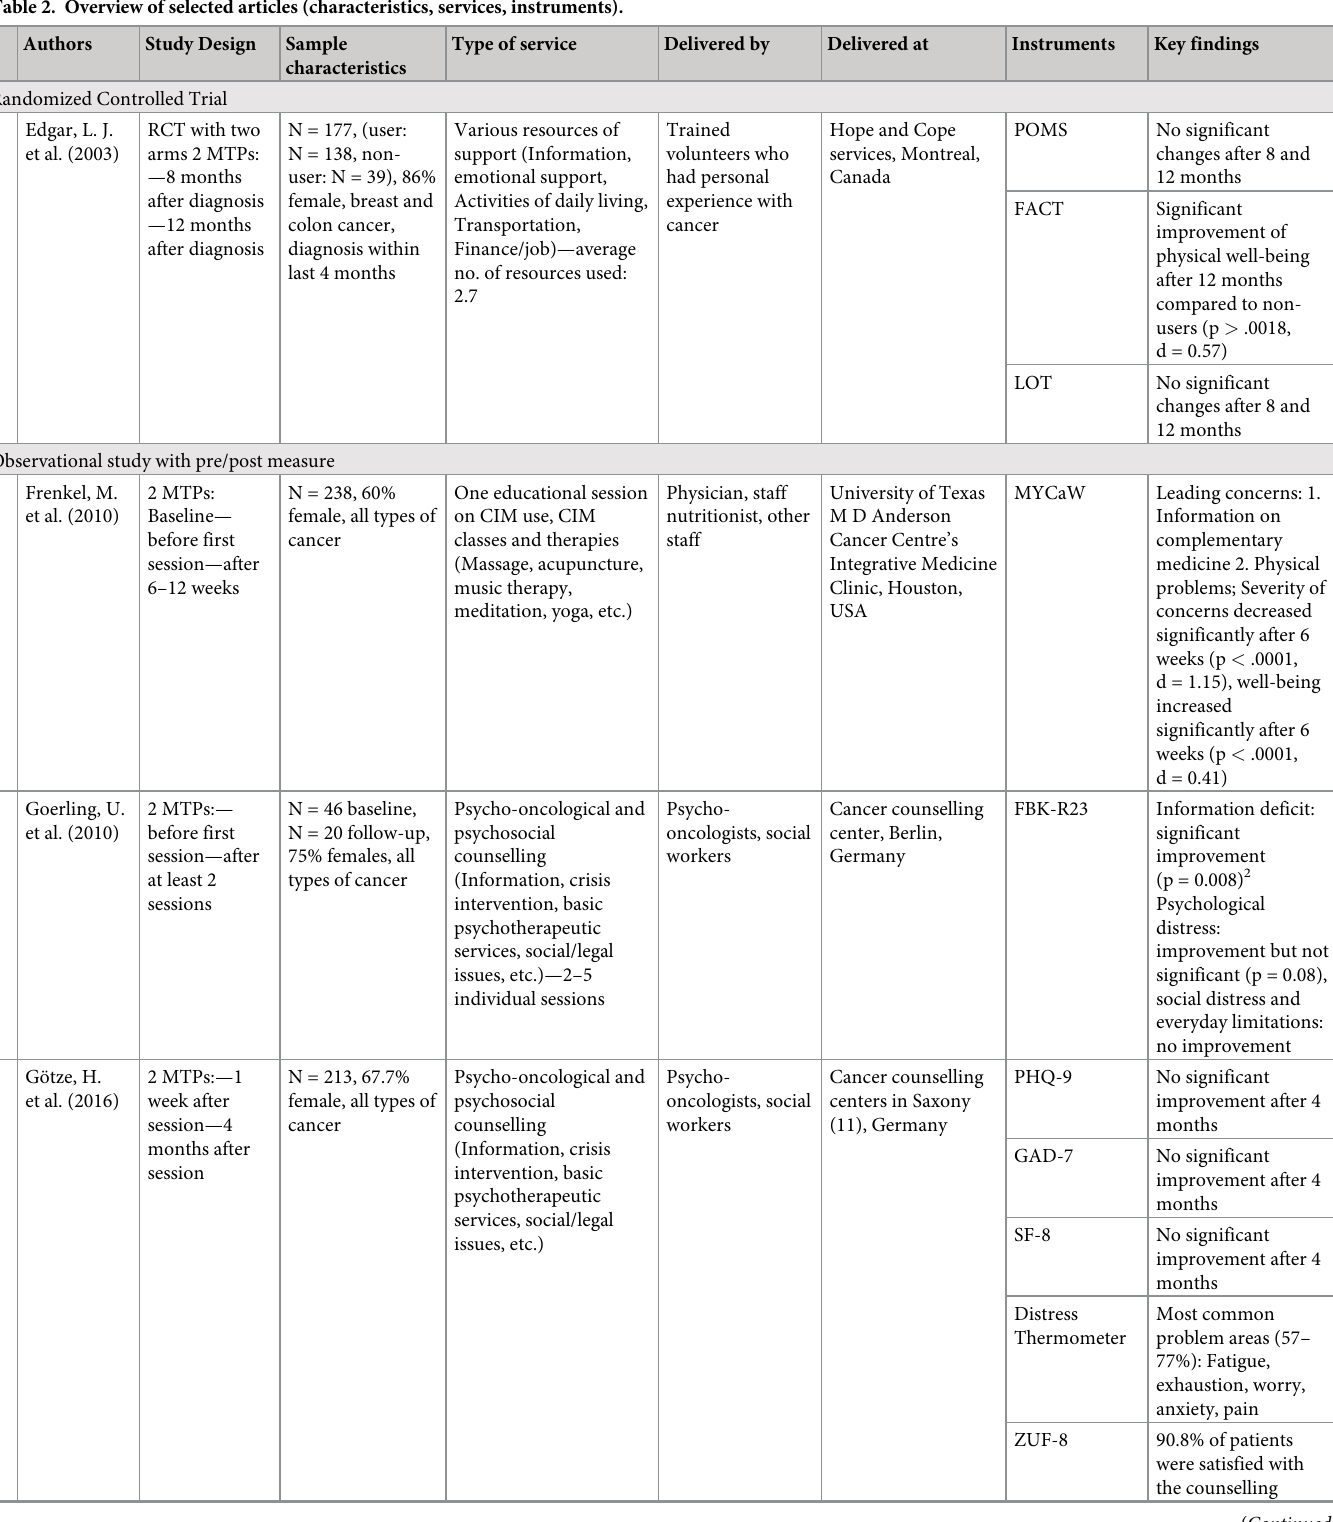
Table 2. Overview of selected articles (characteristics, services,